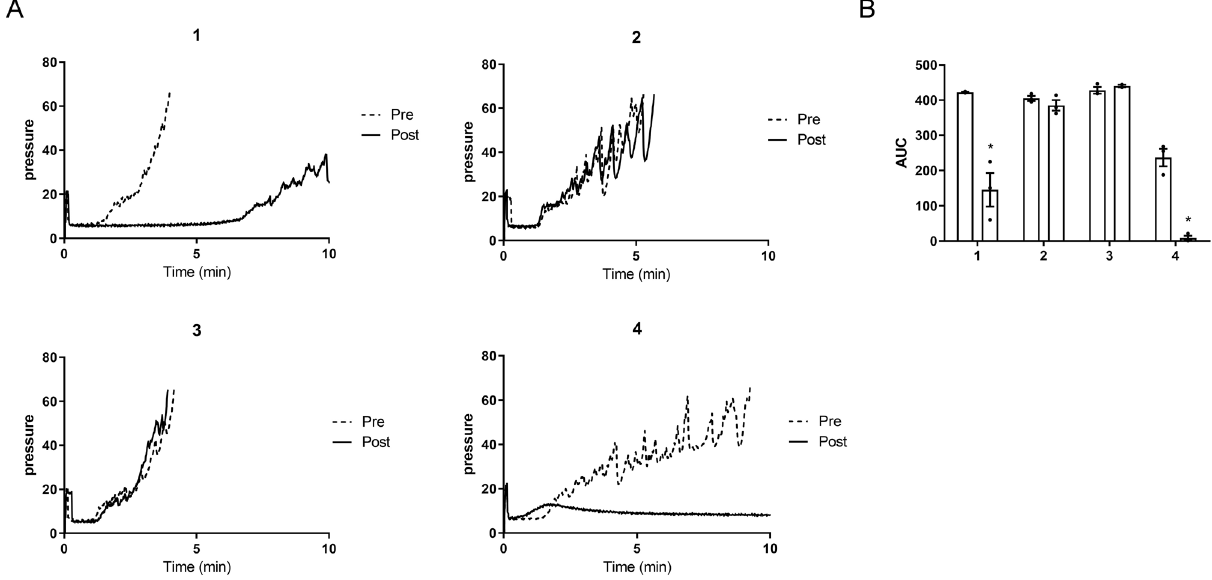
Figure 3. Effect of S100A9 vaccination on thrombus formation. ( A ) Thrombus formation in the mixture of fresh plasma and pre-vaccinated (dotted line) and post-vaccinated (line) serum was evaluated under laminar flow with collagen (T-TAS). ( B ) The AUC in ( A ) was calculated. The post-vaccinated serum from monkeys No. 1 and No. 4 shows a delay in thrombus formation. Data represent the mean ± SEM of 3 times measurements in each group. *Mann–Whitney test, p < 0.05 vs. pre-vaccinated monkey. T-TAS, total thrombus formation analysis system.